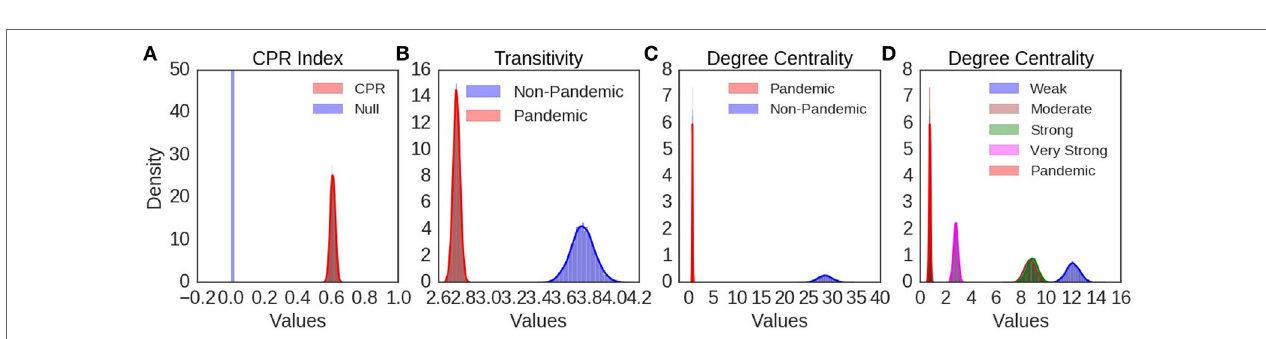
FigUre 6 | Southern oscillation (SOI) and sea surface temperature (SST) joint recurrence. (a) shows periodic, quasi-periodic, and chaotic regimes similar to the Lorenz model in the joint recurrence of annual oscillatory components of SOI and SST. The cross-correlation index in (B) shows the time-varying changes in synchronization of SOI and SST, while (c) shows time-varying changes in transitivity. The arrow heads indicate the timing of the first peak of each influenza pandemics. Metrics were calculated for 36-month windows that spanned 18 months before and after the first peak.